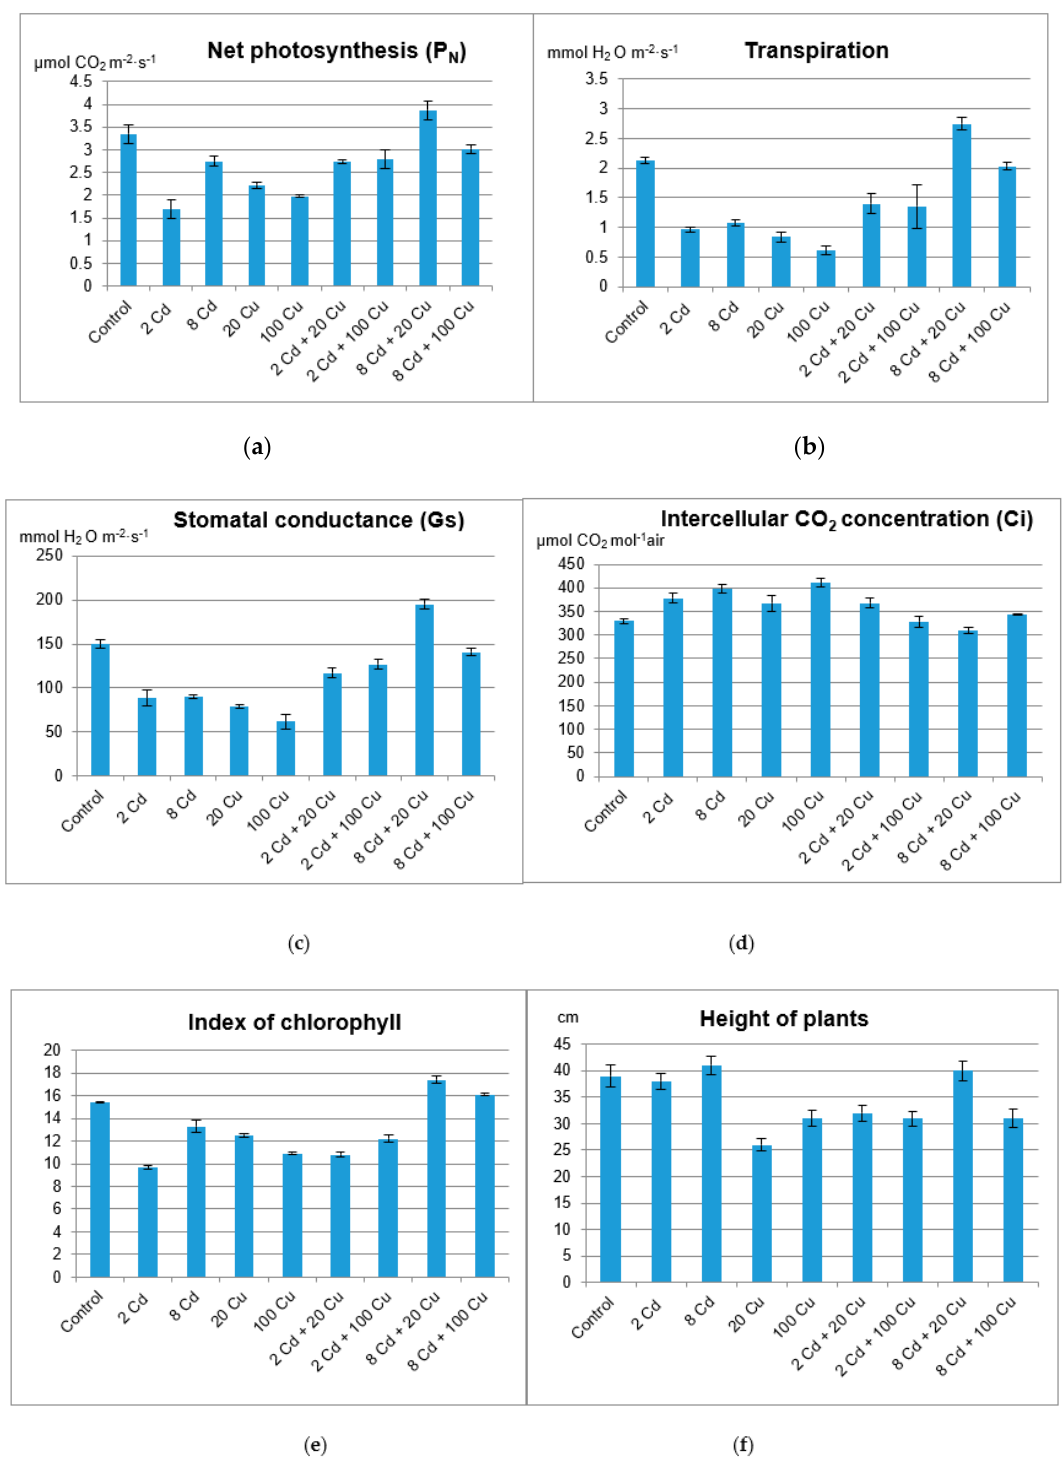
Figure 2. Net photosynthesis ( a ); transpiration ( b ); stomatal conductance ( c ); intercellular CO 2 concentration ( d ); index of chlorophyll content ( e ); height of the plant ( f ) for lemon balm grown on soil either with or without Cd and Cu treatment. 2 Cd = 2 µg/g cadmium; 8 Cd = 8 µg/g cadmium; 20 Cu = 20 µg/g copper; 100 Cu = 100 µg/g copper.